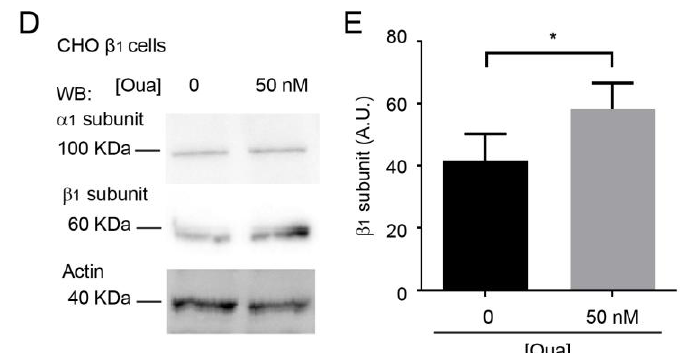
Figure 4. Ouabain increases the expression of the Na +, K + -ATPase at the plasma membrane of CHO fibroblasts transfected with the canine β 1 subunit. ( A ) Representative confocal microscopy images of the canine β 1 subunit in MDCK cells incubated with 10, 50 nM and 10 µ M of Ouabain for 24 h, scale bar = 20 µ m. ( B ) Representative confocal microscopy images of the canine β 1 subunit in CHO β 1 cells incubated for 24 h with 10, 50 nM, 10, and 100 µ M of ouabain, scale bar = 20 µ m. ( C ) Quantification of the fluorescence intensity observed at the plasma membrane of CHO β 1 cells (10 cells per field of three independent biological replicates). One way ANOVA and Dunn´s test for multiple comparisons were performed. The data represent the mean ± SE; NS, non-significant, *** p < 0.0001. ( D ) Representative Western blot analysis of β 1 and α 1 subunits of the Na + ,K + -ATPase of CHO β 1 cells biotinylated after treatment with 50 nM ouabain for 24 h. Actin was used as a loading control for the input of the corresponding samples. ( E ) Densitometry quantification of biotinylated β 1 subunit after treatment with ouabain. The data represent the mean of three independent biological replicates ± SD, Student t-test was performed; * p < 0.05.